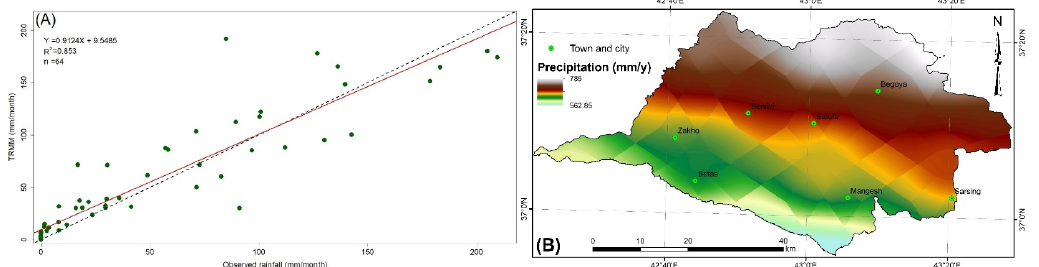
Figure 8. ( A ) Comparison of observed rainfall from Duhok metrological station and the Tropical Rainfall Measuring Mission (TRMM) data for the pixel located at the same site for the period September 2002 to March 2010, and ( B ) precipitation distribution in the study area.